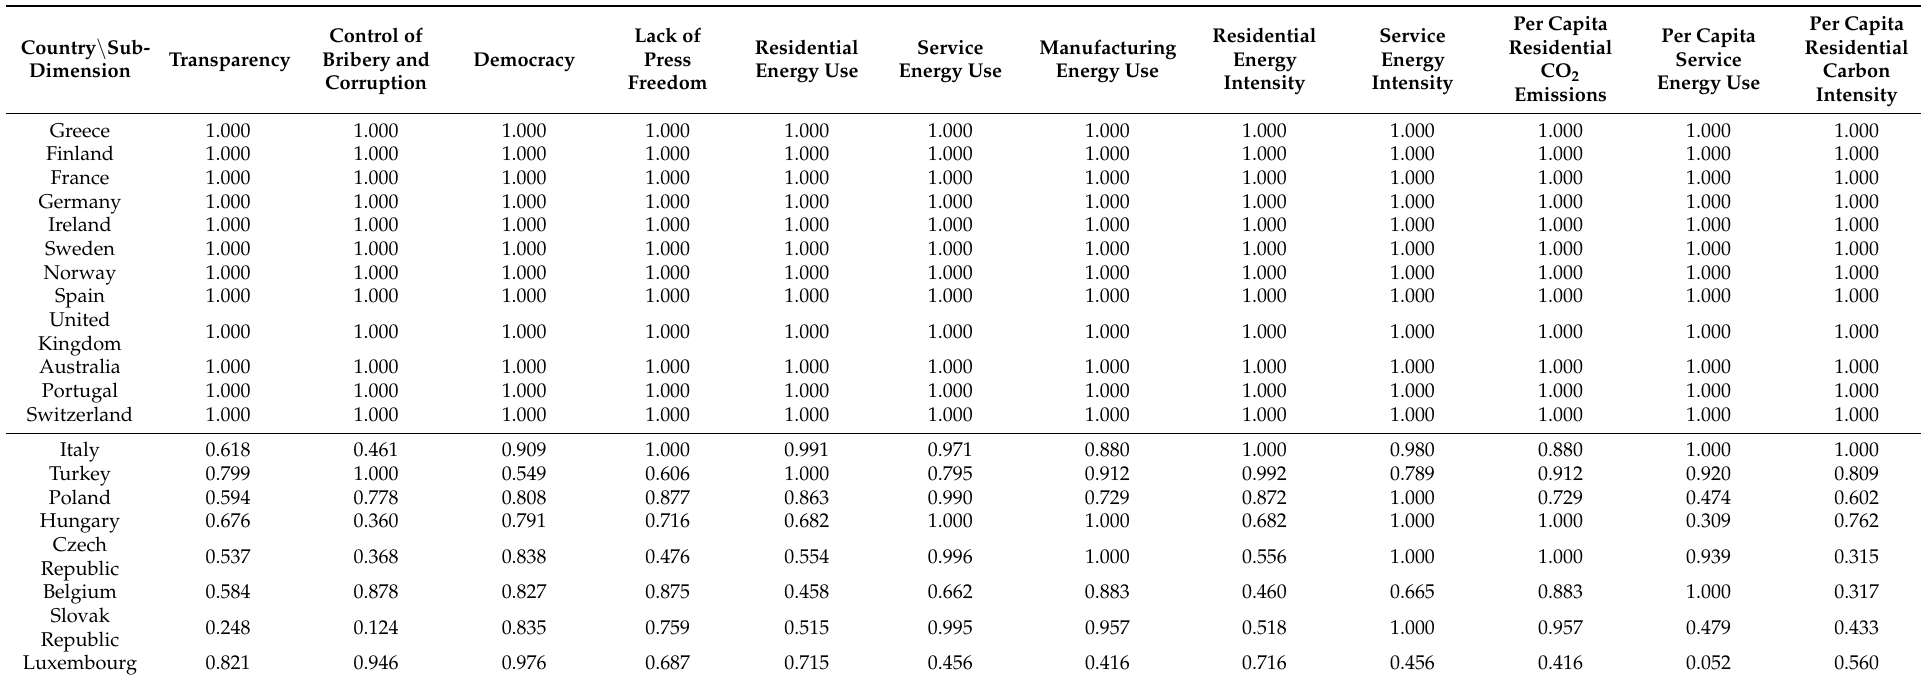
Table 5. Sub-dimensional energy resilience scores of European